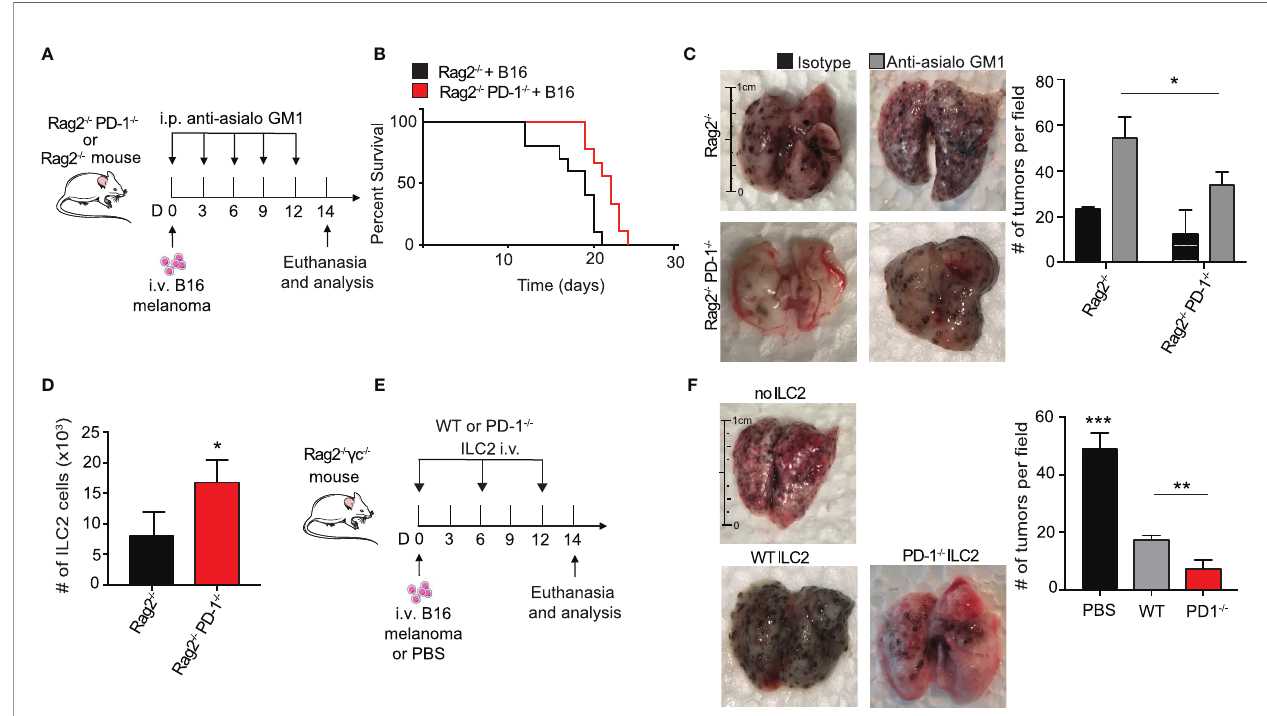
FIGURE 2 | PD-1 expression on pulmonary ILC2s promotes B16 tumor growth and drives melanoma-induced fatality. (A) A cohort of Rag2 -/- or Rag2 -/- PD-1 -/- mice were intravenously injected with B16 melanoma (2.5 x 10 5 ) cells on day 0. Mice were also intraperitoneally injected with anti-asialo GM1 or isotype every three days. On day 14, mice were euthanized and lung tumor burden per fi eld was assessed and quanti fi ed. (B) Kaplan-Meier survival curves of Rag2 -/- or Rag2 -/- PD-1 -/- mice intravenously injected with B16 melanoma. (C) Whole lungs were isolated on day 14 and total tumors per fi eld on lung surfaces were quanti fi ed. Representative lungs for the cohorts are presented. (D) Total number of lung ILC2 cells in Rag2 -/- or Rag2 -/- PD-1 -/- mice on day 14. (E) A cohort of Rag2 -/- g c -/- mice were intravenously injected with B16 melanoma cells (2.5 x 10 5 ) on day 0. Activated PD-1 -/- or WT ILC2s were adoptively transferred intravenously on days 0, 6 and 12. Mice were euthanized on day 14 and lung tumor burden was quanti fi ed (F) . Error bars are the mean±SEM. Data are representative of 3 individual experiments with n=5. Student ’ s t-test, *p<0.05, **p<0.01,